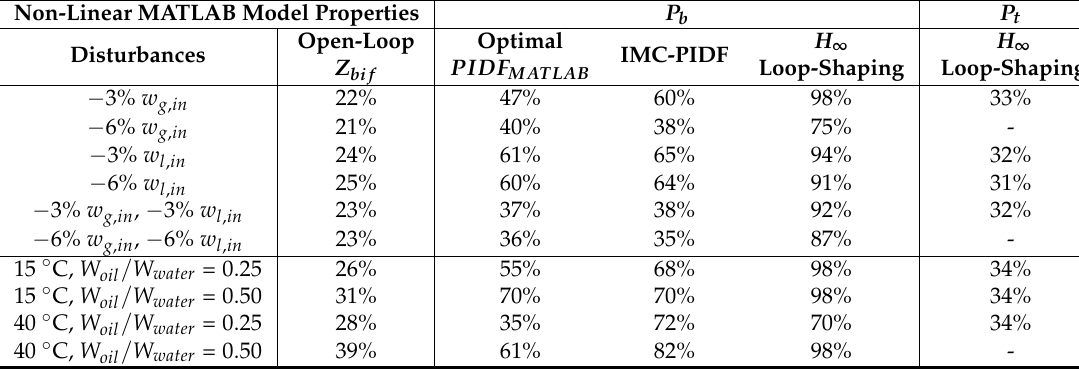
Table 9. Controller comparison between P b and P t with input and parametric disturbances based on non-linear MATLAB simulations. The result entries show the new bifurcation points for each disturbed system with the controllers from Table